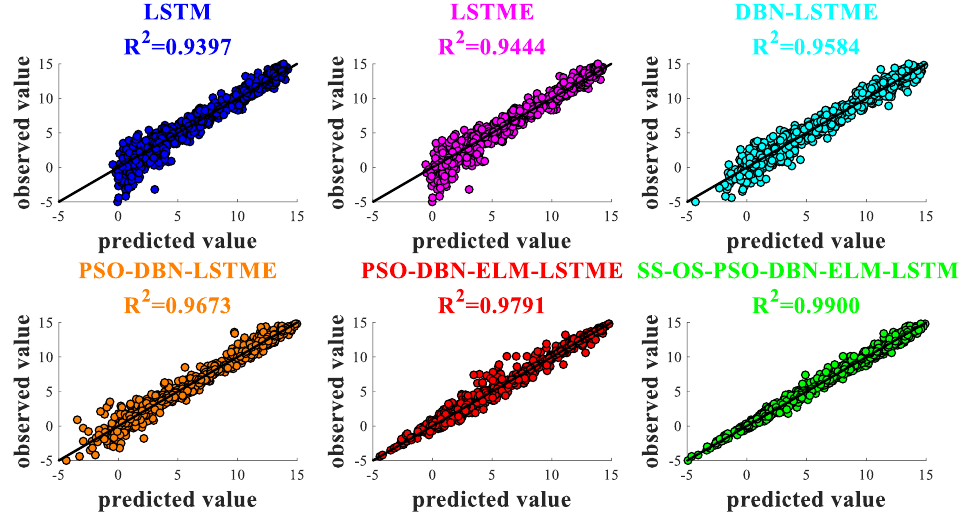
Figure 11. Scatter plots of observed and predicted lowest temperature (unit: °C) using M1 − M6 models.